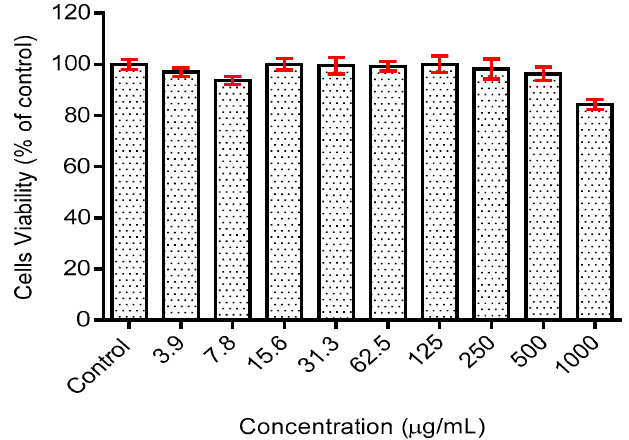
Figure 2. Cytotoxicity effects of phycocyanin on the HSF1184 cell. Table 1. Antioxidant activity of the